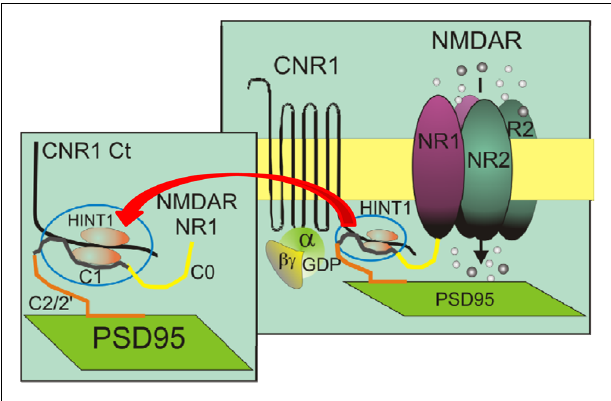
FIGURE 1 |The role of HINT1 proteins in the direct interaction between the C-terminal sequences of CB1 and the NMDAR NR1 subunits. Both CB1 and the NR1 subunits interact with the HINT1 protein (Sánchez-Blázquez etal., 2013b).This model describes the physical interaction between the CB1 C-terminus and the NR1 C1 segment, as well as both proteins with the HINT1 protein, which strengthens their